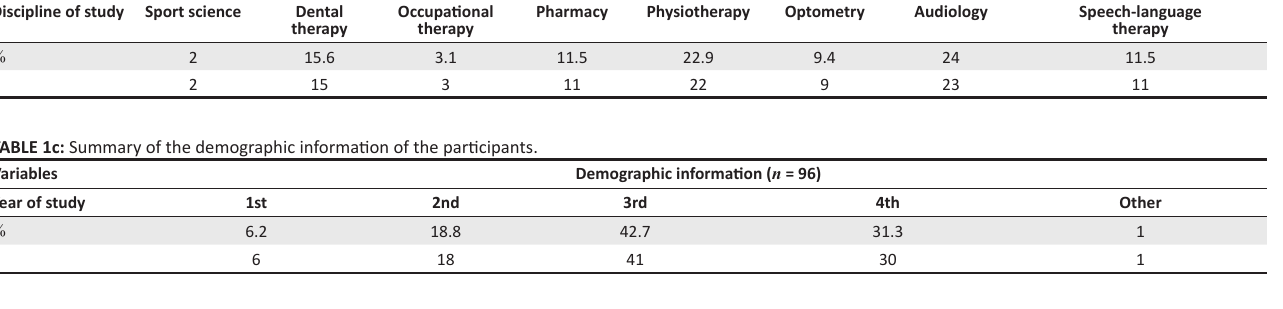
TABLE 1b: Summary of the demographic information of the participants. Variables